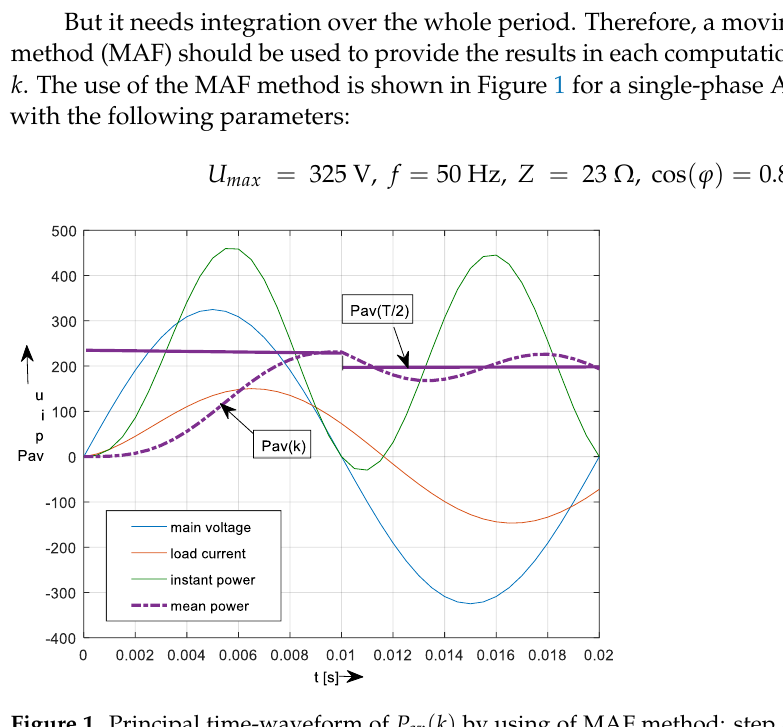
Figure 1. Principal time-waveform of 𝑃 𝑎𝑣 (𝑘) by using of MAF method: step 𝑘 = 0.5 ms, length of sliding window 𝑙 = 𝑇/2 = 0.01 s. sliding window l = T /2 = 0.01